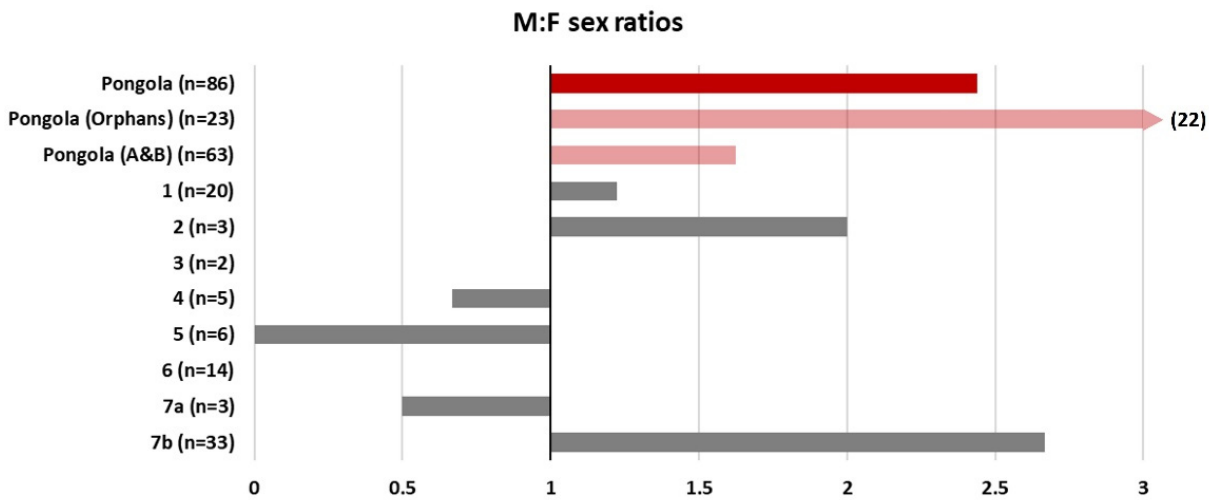
Figure 9. Sex ratios at birth for a number of socially disrupted elephant populations across South Africa. Reserve names have been anonymised. Pongola is shown in red, and the two herds are separately shown in pink. All other reserves are shown in grey. Note that the sex ratios of calves born to the Orphans extend beyond the bounds of the plot. Reserve 5 consists of a group of ex-trained elephants, and 7a and 7b are originally one group split by management within the same reserve.